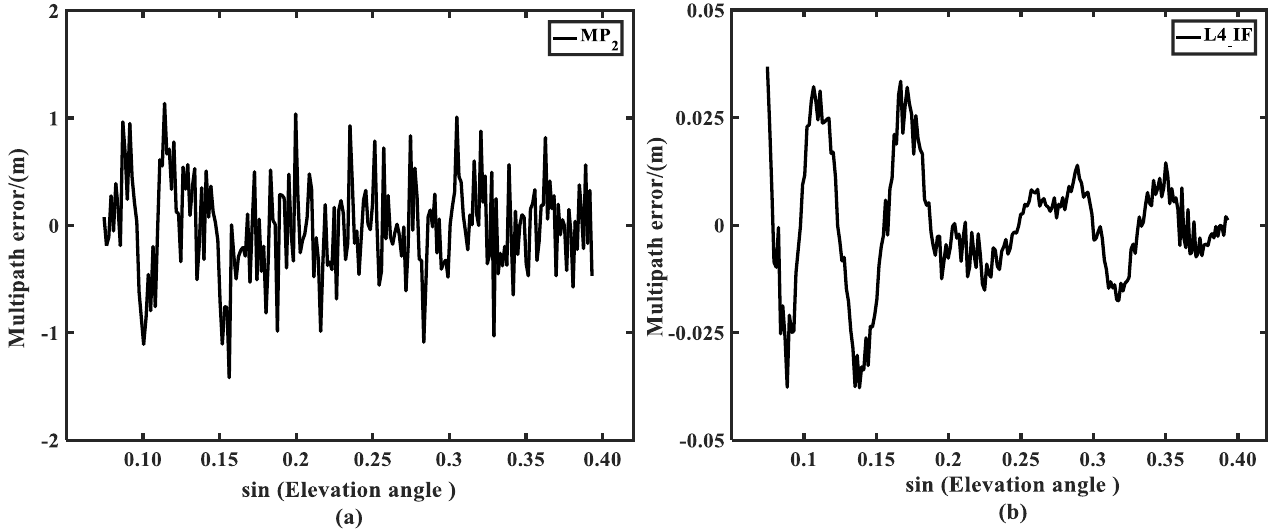
Figure 8. The multipath error of low elevation angle varies with the sine value of satellite elevation angle: ( a ) the dual-frequency pseudo multipath error MP 2 ; ( b ) the dual-frequency carrier phase linear combination multipath error L4_IF for removing ionospheric delay.